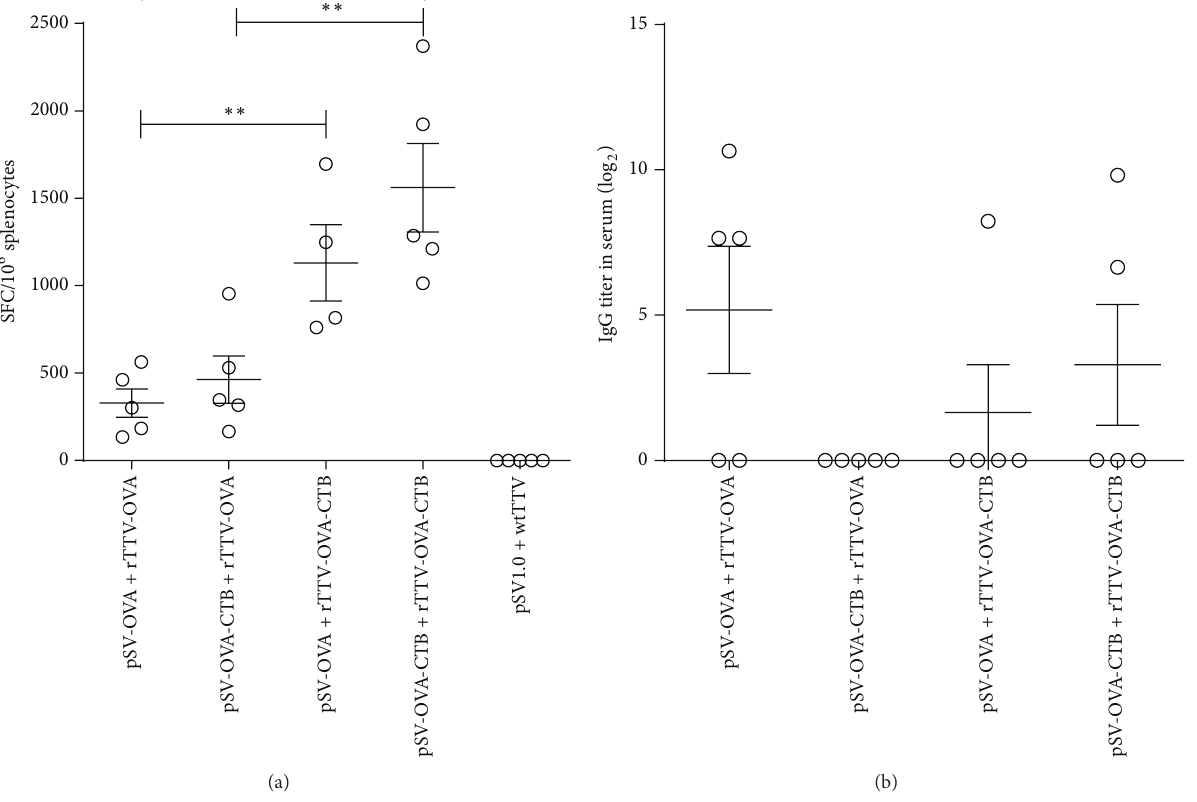
Figure 1: Humoral and cellular immune responses at systemic level. (a) Ovalbumin specific T-cell responses in spleen. The cellular responses elicited in rTTV-OVA-CTB boosting groups were significantly stronger than those elicited in rTTV-OVA boosting groups. (b) Ovalbumin specific antibody responses in serum. OVA specific IgG titers elicited by adjuvant groups tended to be lower than the nonadjuvant group, but no statistical significance was reached. ∗∗ 𝑃 < 0.01